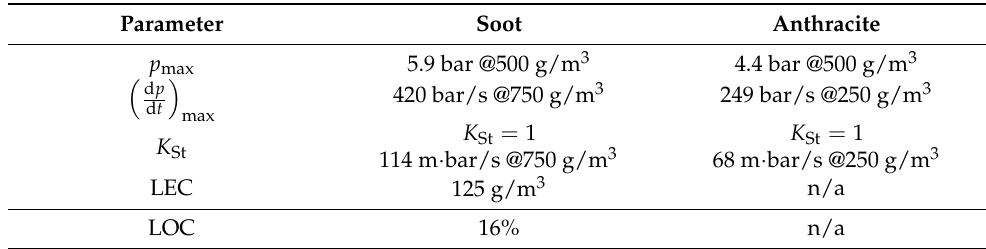
Table 4. Comparison of the explosion parameters for the tested sample and anthracite as the refer- ence material.